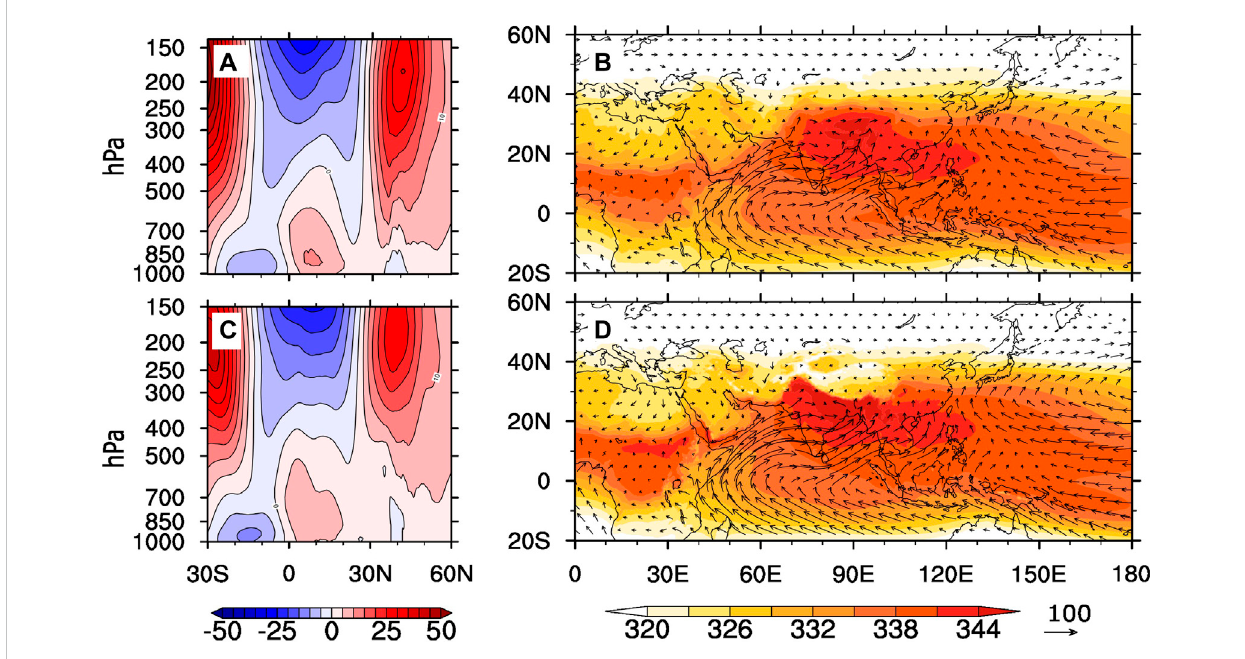
FIGURE 3 Latitude — Pressure section of JJAS time-mean zonal winds (ms -1 ) averaged over the longitudes (75 o E-95 o E): (A) HIST (C) ERA5. Moist static energy (MSE) (in 10 3 Jm -2 ). Moisture transport (vector) (kgm -1 s -1 ) vertically averaged from surface to 300 hPa (B) HIST (D)